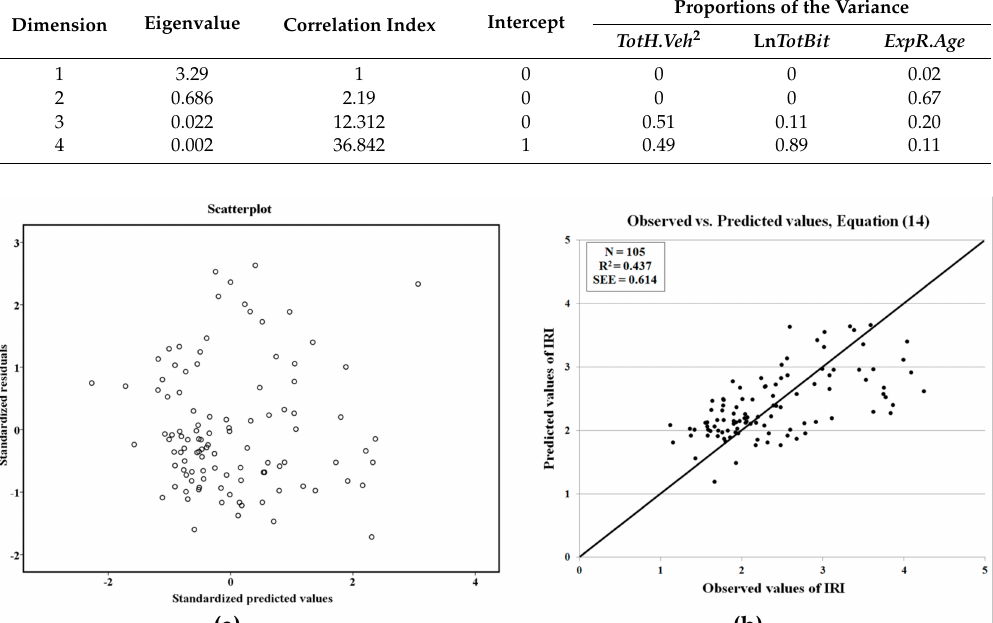
Figure2. AnalysisinEquation(14). ( a )Scatterplotofthestandardizedpredictedvaluesvs. standardized residuals; ( b ) Observed values vs. Predicted